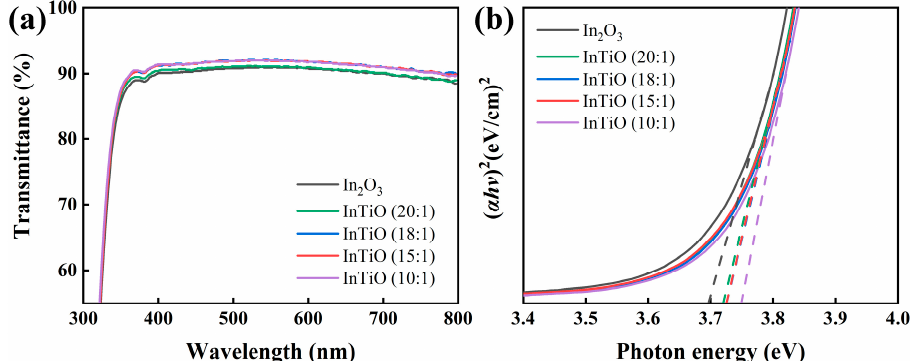
Figure 3. ( a ) The optical transmission spectra and ( b ) the optical bandgap of thin films deposited on quartz glass. quartz